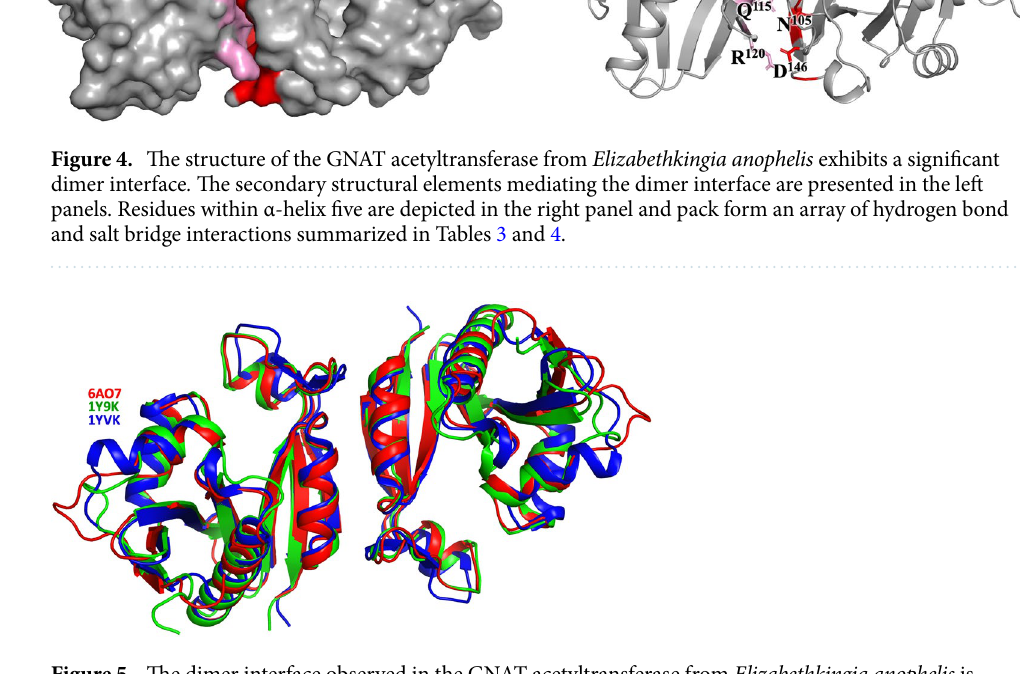
Figure 5. The dimer interface observed in the GNAT acetyltransferase from Elizabethkingia anophelis is conserved in two other unpublished structures. Superposition of the two structures (PDBs 1Y9K (green) and 1YVK (blue), both unpublished), demonstrate a conserved dimer